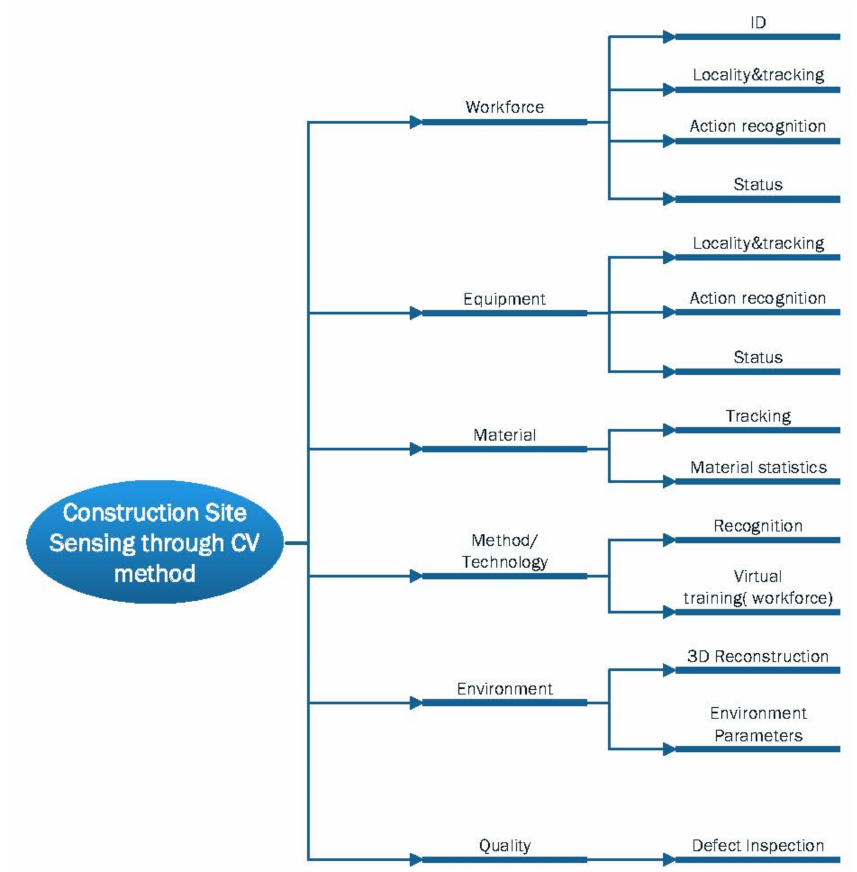
Figure 4. Computer vision-based construction site